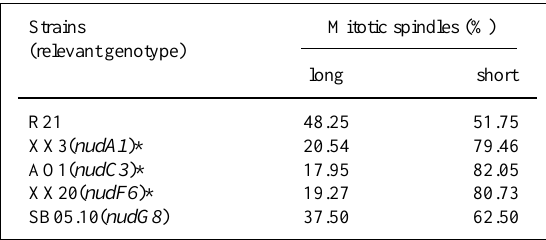
Figure 1 - Indirect immunofluorescence microscopy of microtubule cytoskeleton structure and DAPI staining of the XX20 mutant (A) and control strain R21 (B) of Aspergillus nidulans ; mitotic spindle and astral microtubules are seen (arrows).